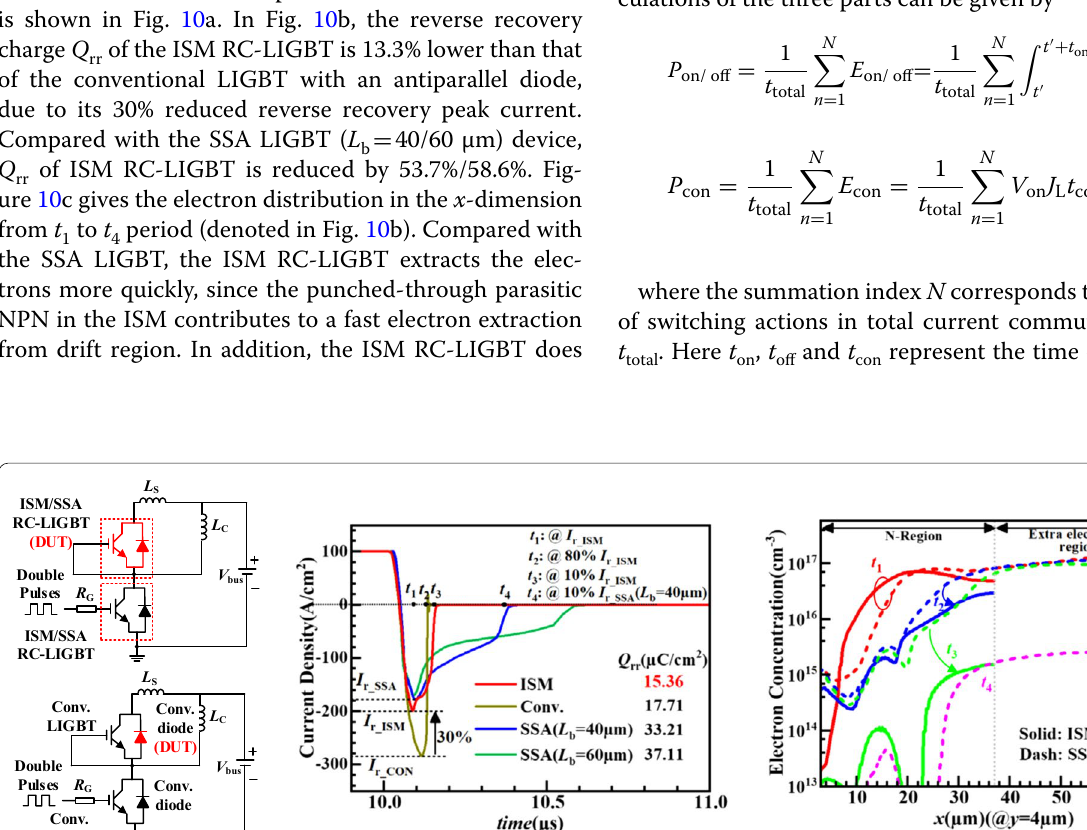
1mH, L S 1nH, R G 25Ω, V bus 200 V, V on 2 V); b reverse recovery waveforms; c electron concentration distribution along = = = = =